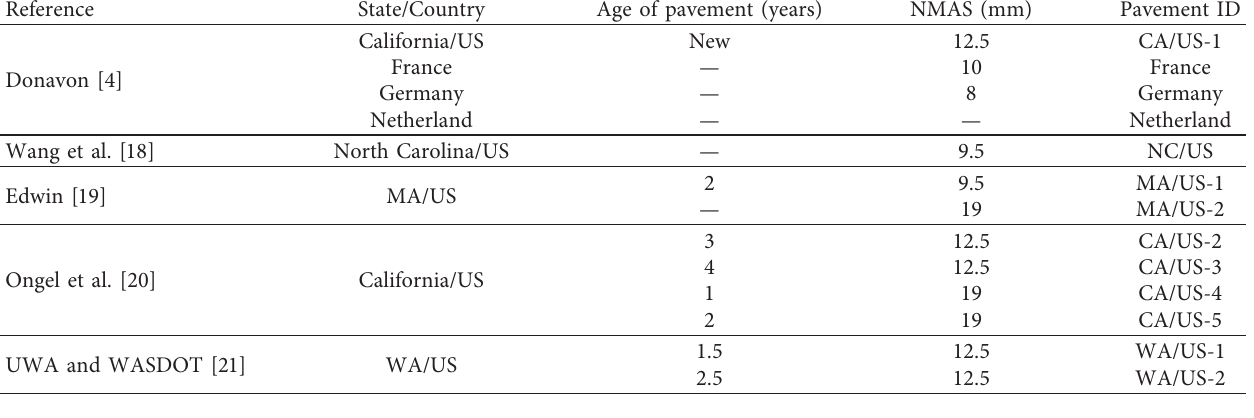
Table 4: Available pavement data for dense-graded asphalt pavement surfaces in the US and Europe.